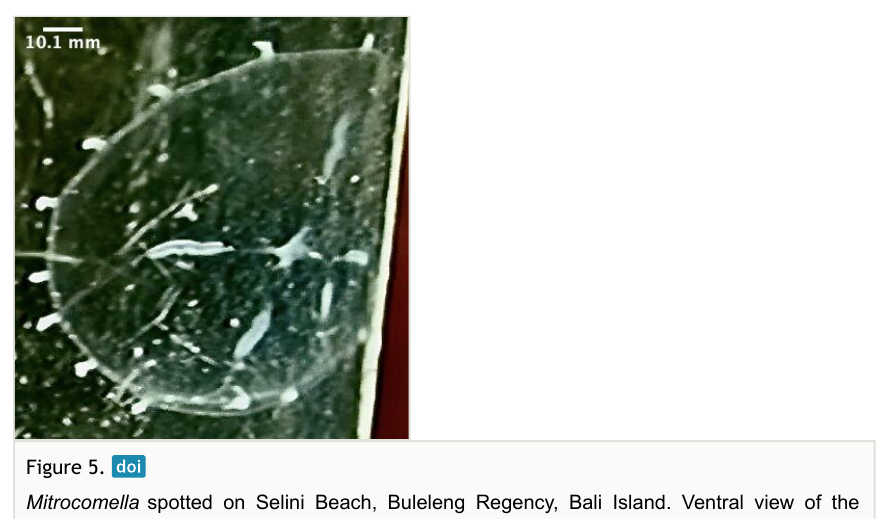
Mitrocomella spotted on Selini Beach, Buleleng Regency, Bali Island. Ventral view of the